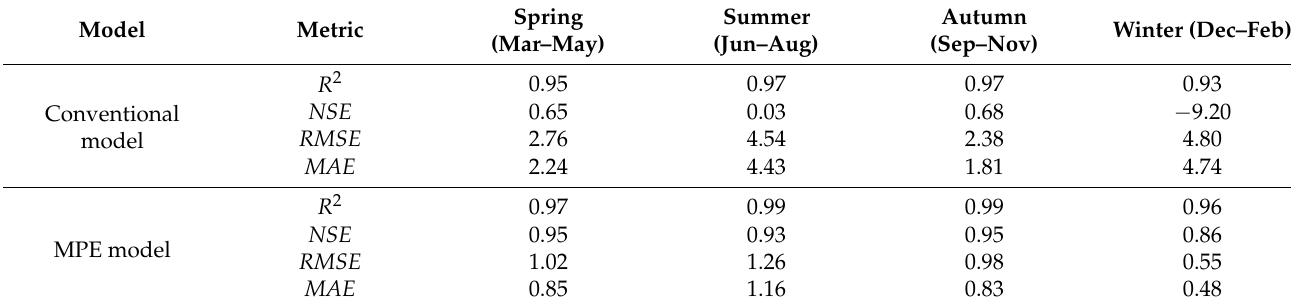
Table 6. Comparison of performance of both models for seasonal low